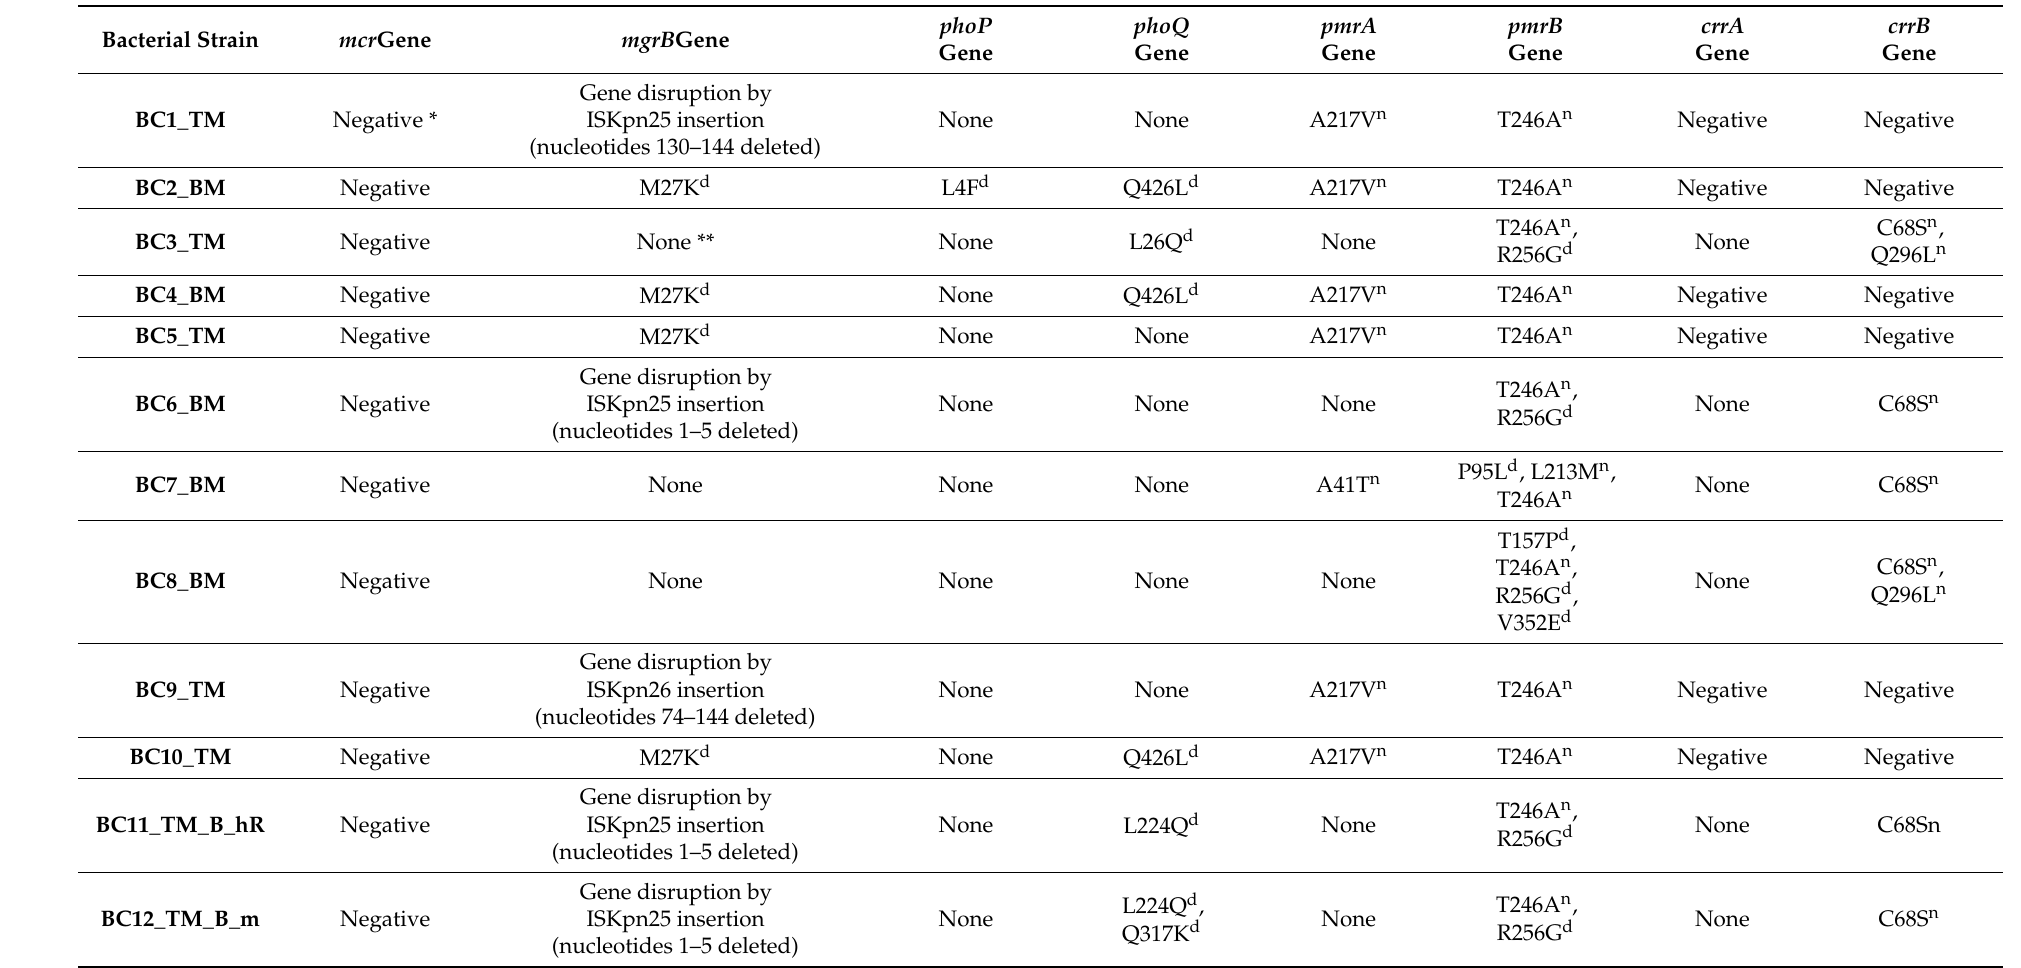
Table 5. Cumulative colistin resistance